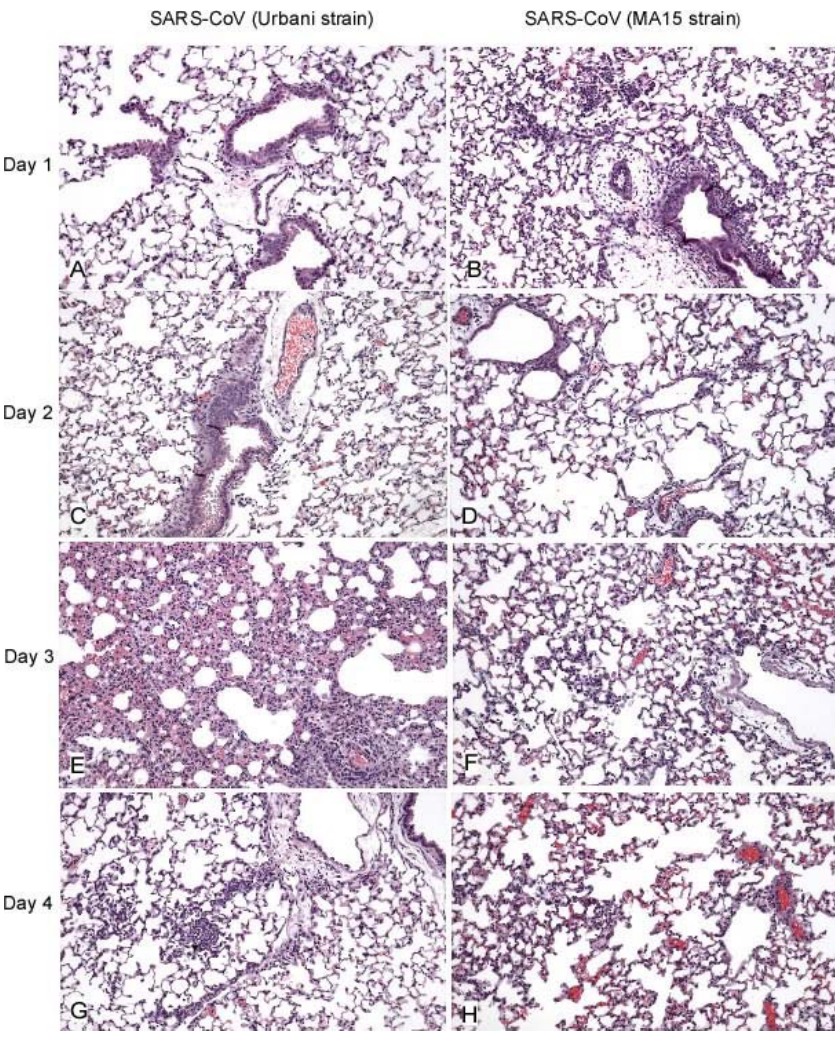
Figure 4. Histopathological Changes in Lungs from SARS-CoV (Urbani)–Infected and MA15-Infected Mice (Hematoxylin and Eosin Stain, Original Magnifications 3 25) Day 1 p.i. (A) SARS-CoV (Urbani)–infected mice: no significant inflammatory cell infiltrates. (B) MA15-infected mice: foci of perivascular, peribronchiolar, and interstitial inflammatory infiltrates comprised predominantly of mononuclear cells. Day 2 p.i. (C) Same as in (A). (D) MA15-infected mice: small, mononuclear inflammatory cell focus in the alveolar interstitium. Day 3 p.i. (E) SARS-CoV (Urbani)–infected mice: extensive and confluent interstitial pneumonitis. (F) MA15-infected mice: mild interstitial